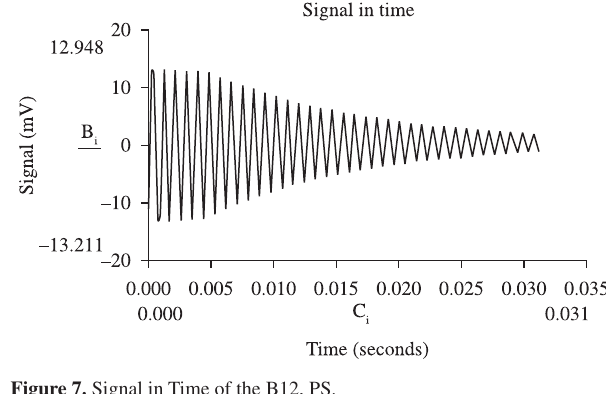
Figure 7. Signal in Time of the B12, PS.